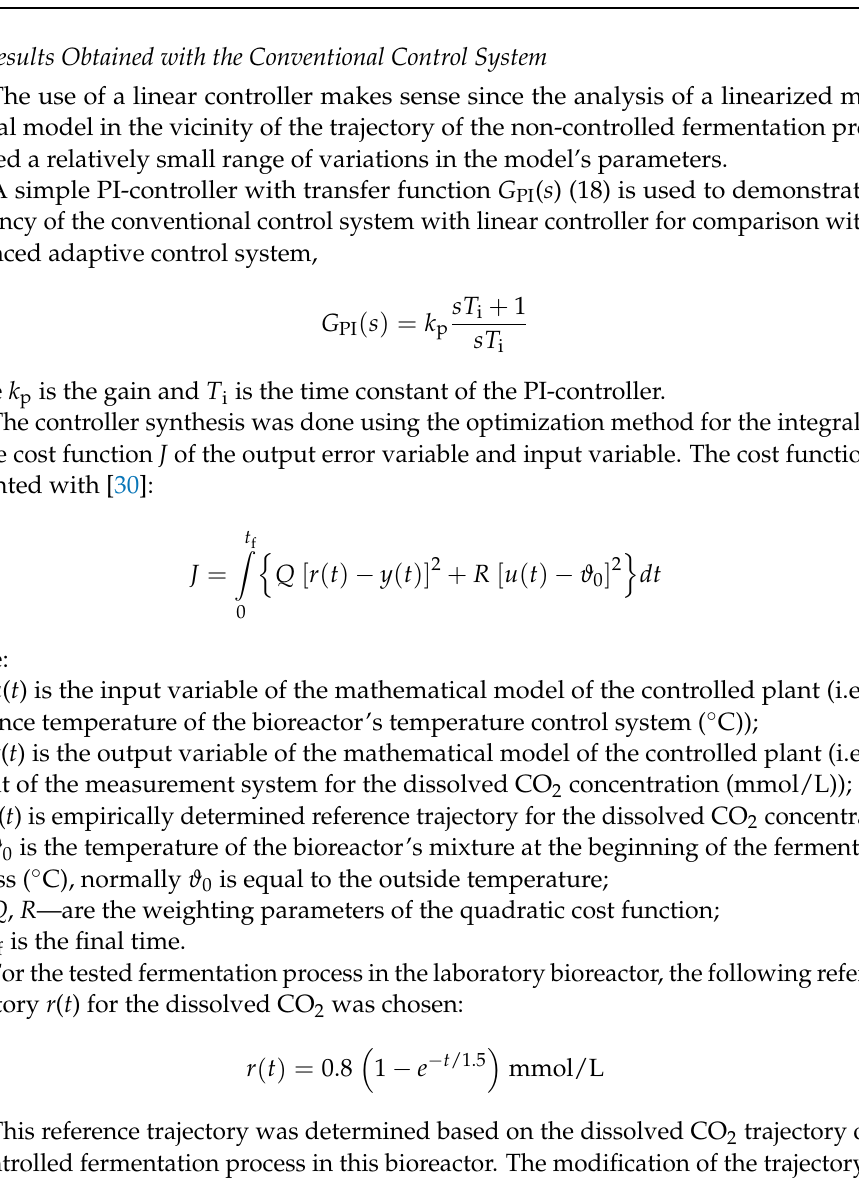
Table 3. Parameters of the mathematical model for the modified fermentation process in the studied laboratory batch bioreactor where inactivated kefir grains were used. Parameter Value The maximum microorganisms’ growth rate µ m = 0.23 h − 1 The product inhibition constant P i = 7.2 g/L The substrate saturation constant S m = 0.67 g/L The substrate inhibition constant S i = 74.58 g/L The parameter of the product yield related to microorganisms’ growth α = 0.8 g/L g/L The parameter of the product yield independent of the microorganisms’ β = 0 h − 1 growth The coefficient of the impact of the temperature on the maximum k µ = 0.12 ( ◦ C) − 1 m microorganisms’ growth rate inhibition constant P